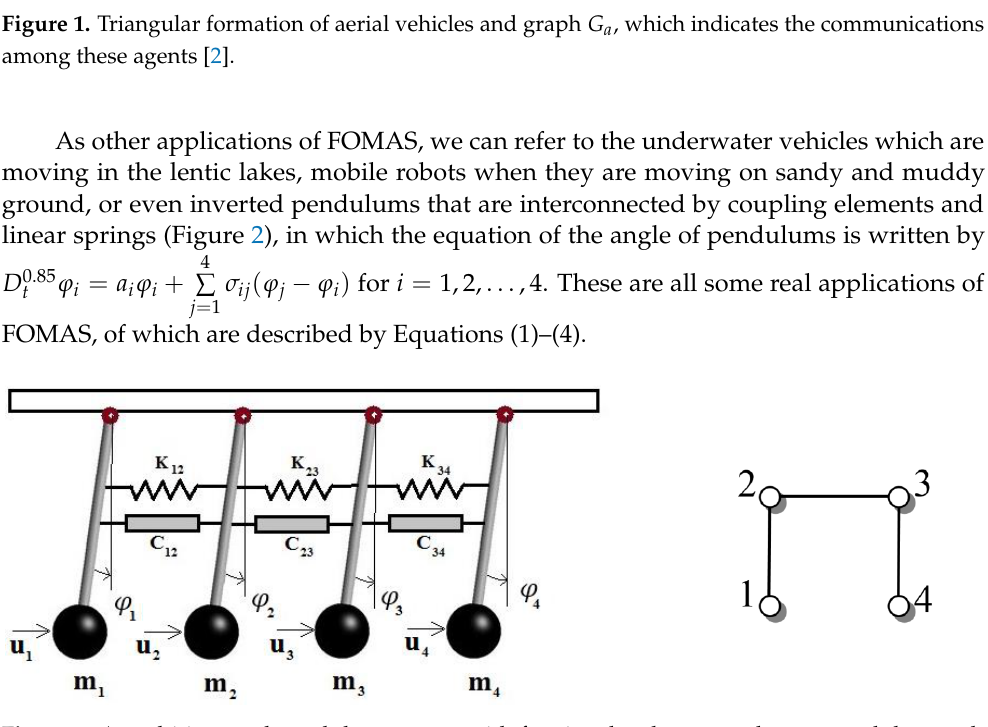
Figure 2. A multi-inverted pendulum system with fractional-order creep elements and the graph that shows the connection among them [2].